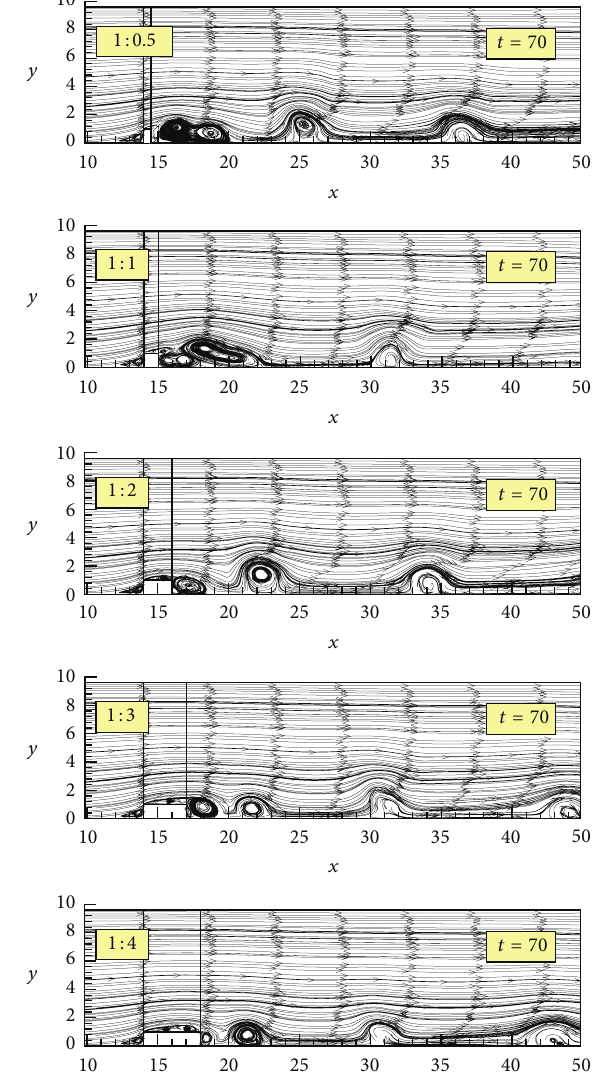
Figure 2: Instantaneous streamline flow patterns for 𝑡 = 70 for the five rib